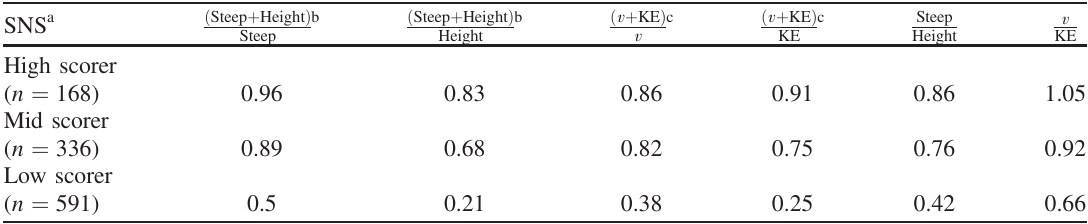
TABLE XI. Robustness of the concept of energy conservation with respect to the SNS level. SNS